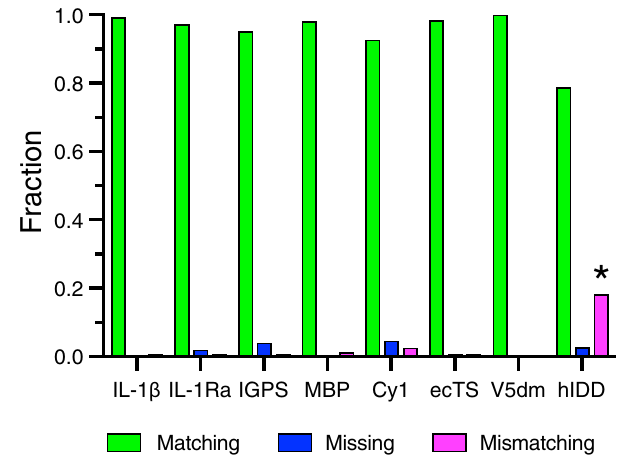
Fig. 3 | Performance ofBARASA using a comprehensive set oftriple resonance experiments. Comparison of automated assignment algorithms. Results of auto- mated resonanceassignmentsby BARASAutilizing raw crosspeaklists drawn from a relatively comprehensive set of triple resonance experiments. Compared to manually curated resonance assignments obtained for eight test proteins: interleukin-1 β (IL-1 β ), interleukin-1 receptor antagonist (C66A, C122A) (IL-1Ra); indole-3-glycerol phosphate synthase (R43S) (IGPS), maltose binding protein (MBP), non-ribosomal peptide synthetase (Cy1), thymidylate synthase (ecTS), V5 domain of protein kinase C (V5dm), and intrinsically disordered region of human ANP32A (hIDD). Shown are the fractions of residues that are accurately matched (green),mismatched(magenta),ormissing(i.e.,unassigned)(blue)tothereference assignments.*InthecaseofhIDD,anumberofdenovoassignmentswereindicated by BARASA and are included as mismatching with the reference assignments. See main text and Table 1. Source data are provided in the Source Data fi